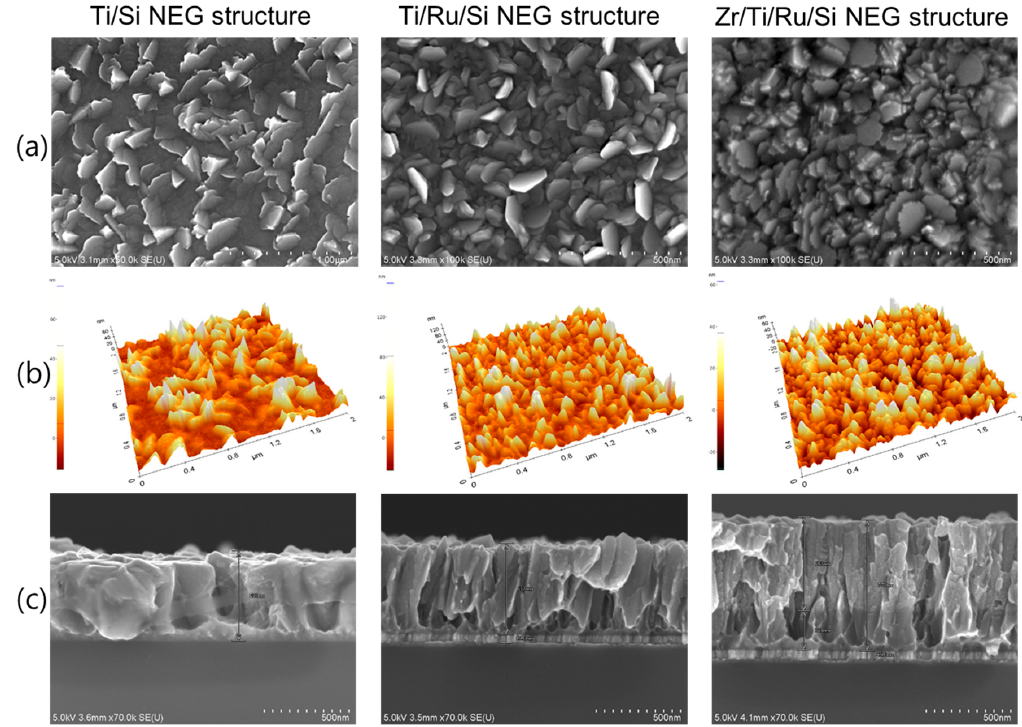
Figure 2. SEM surface micrographs ( a ), 3–D AFM images ( b ), and SEM fracture cross-section micrographs ( c ) of single Ti/Si NEG (left column); multilayer Ti/Ru/Si NEG (middle column) and multilayer Zr/Ti/Ru/Si NEG (right column).